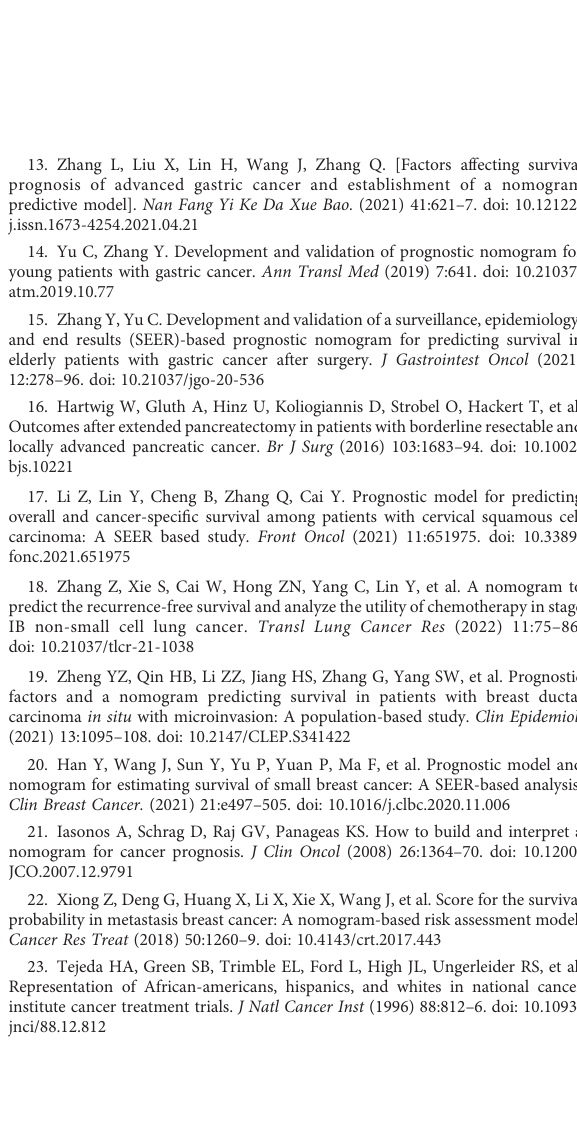
SUPPLEMENTARY TABLE 2 AUC for the nomograms and TNM 7th stage in patients with LAGC. SUPPLEMENTARY TABLE 3 SEER database original data. SUPPLEMENTARY TABLE 4 External validation original